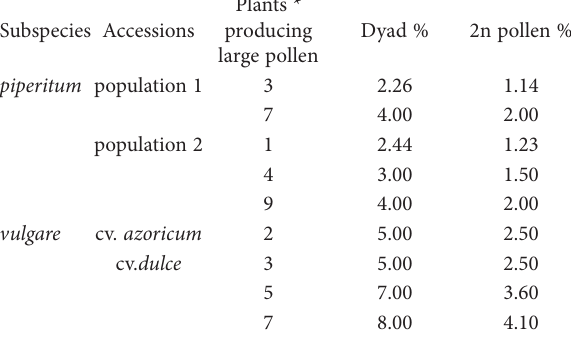
*Plants examined were numbered from 1 to